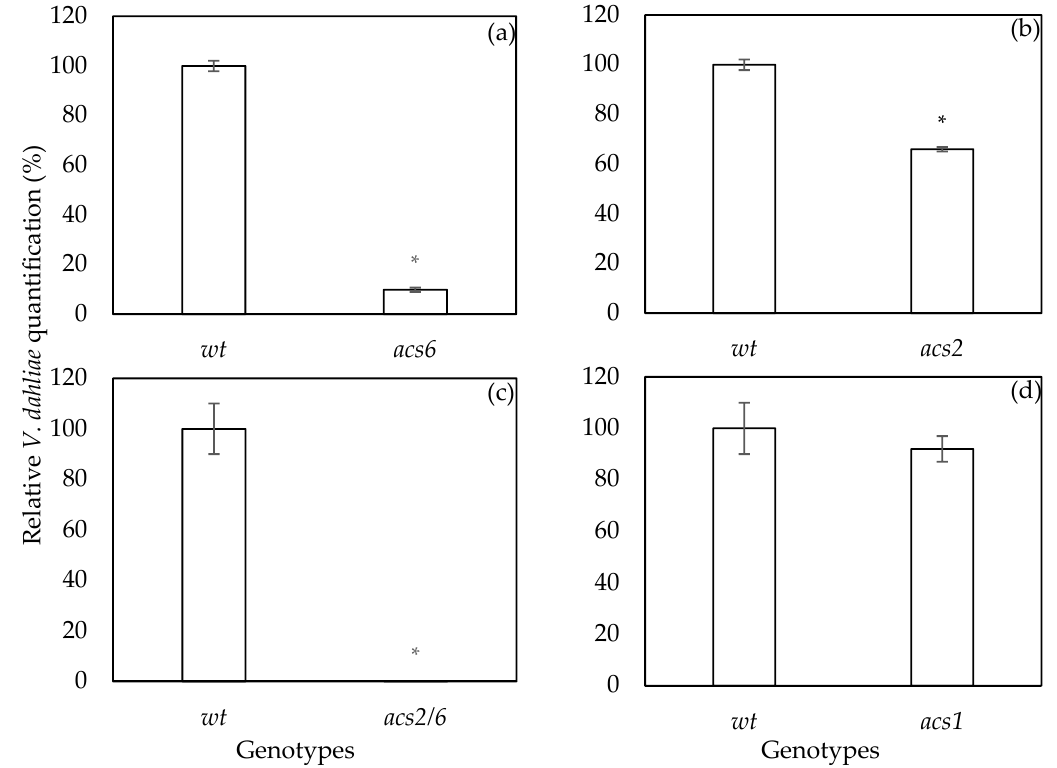
Figure 3. Relative quantification of the V. dahliae DNA levels in the Arabidopsis mutants acs6 ( a ), acs2 ( b ), acs2/6 ( c ), acs1 ( d ), and wild type Col-0 plants. Fungal DNA levels were estimated by qPCR using total DNA isolated from the aerial parts of plants at 21 days post-inoculation. The columns represent the means of 3 biological repeats (with 10 plants per genotype and repeat) and 3 technical repeats per biological repeat (total of nine reactions per treatment). The vertical bars indicate the standard errors. Wild type is set to 100%. Columns with asterisks (*) are significantly different ( p < 0.05) from wt according to a t -test.